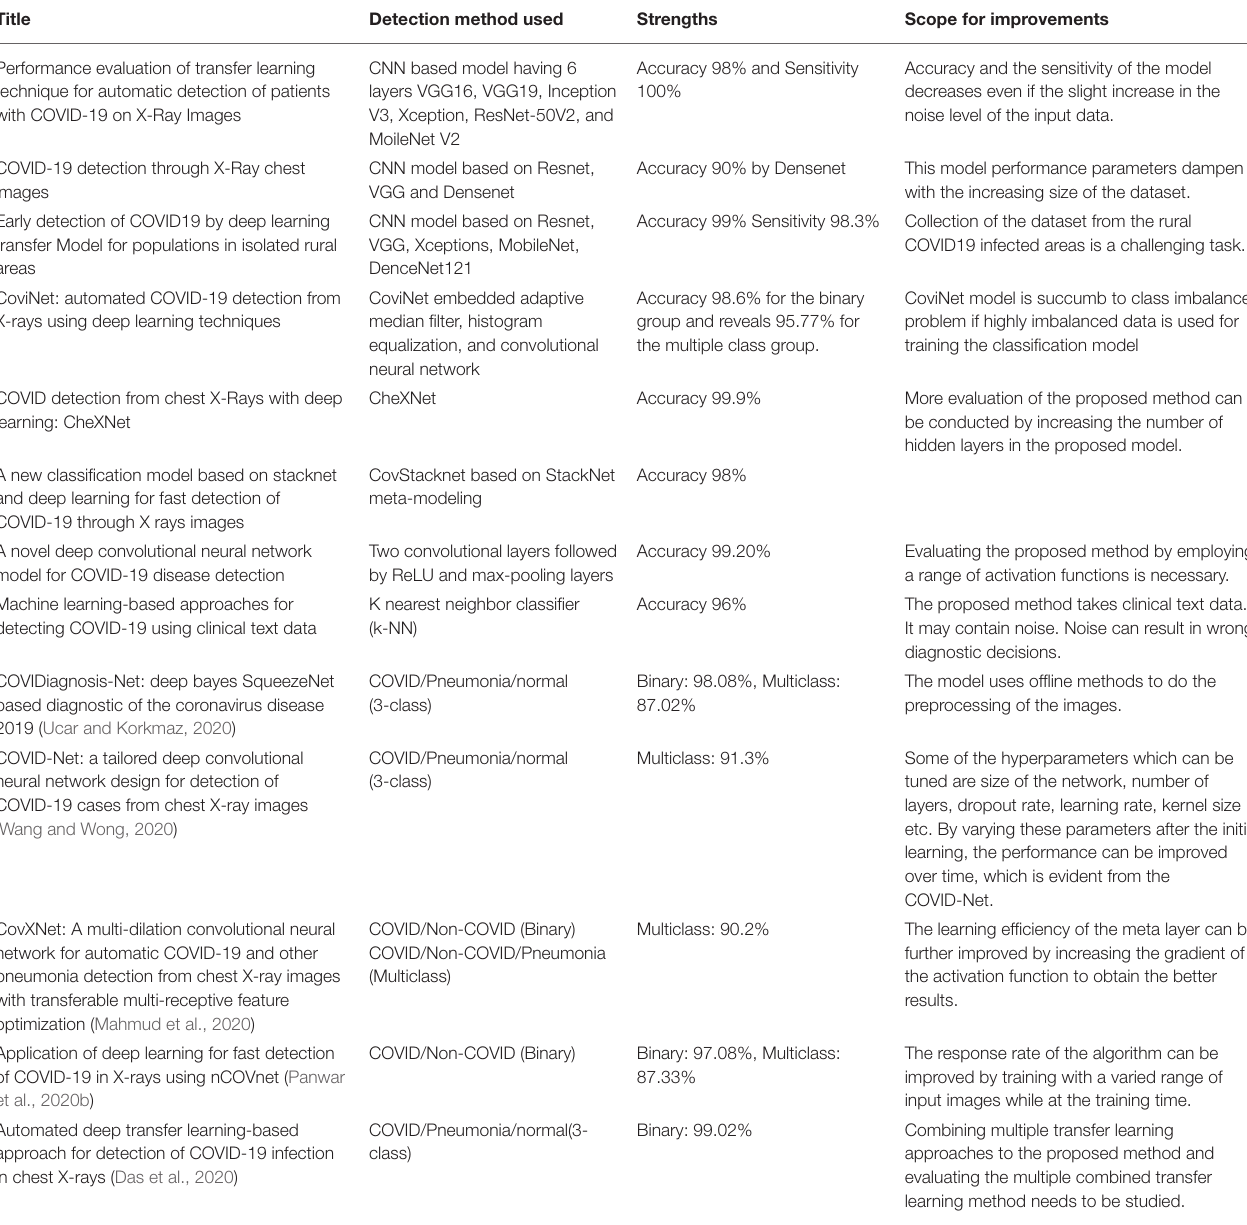
TABLE 4 | Comparison of various models on